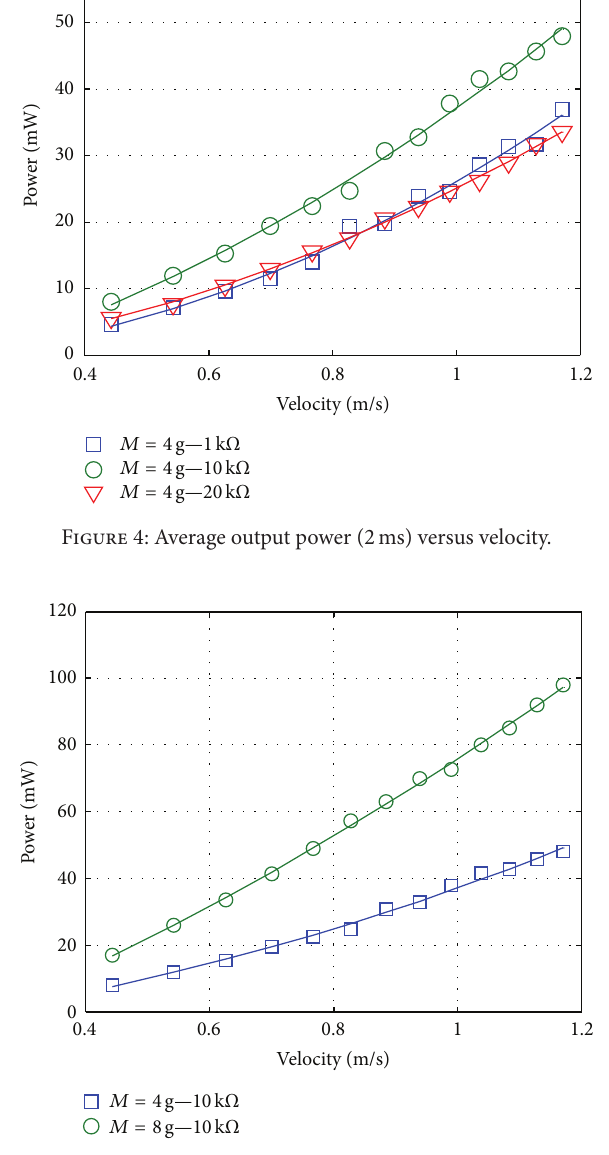
Figure 5: Average output power (2ms) versus velocity plots for 4 g and 8g steel balls.